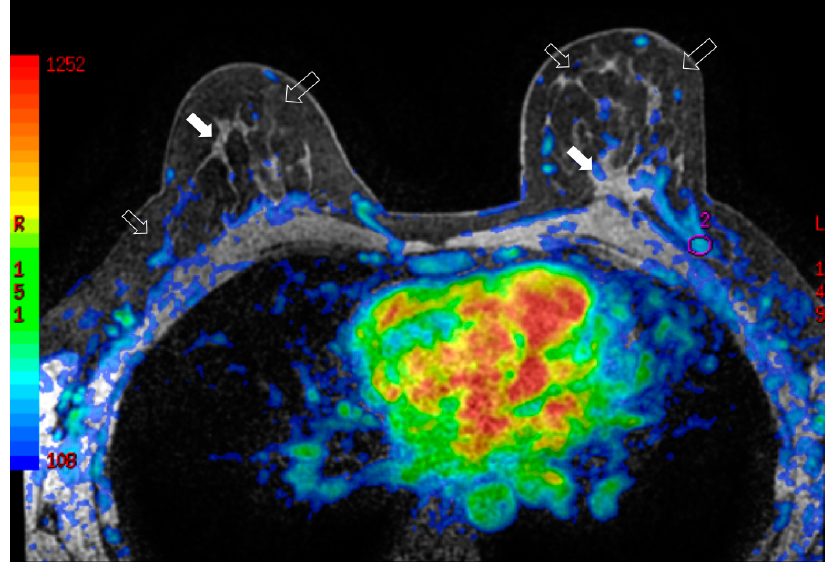
Figure 4. Bilateral three-dimensional MRI T1-weighted spoiled turbo gradient echo image after contrast media administration (colored superimposed image). Using a special fat saturation and separate shim volumes on each breast, VIBRANT sequence (Volume Imaging for Breast Assessment) allows axial acquisition with an excellent separation of glandular tissue (white arrows) from fat tissue (white empty arrows). The velvet region of interest shows how the vascularity of the left breast compared to the contralateral breast after fat grafting is increased.